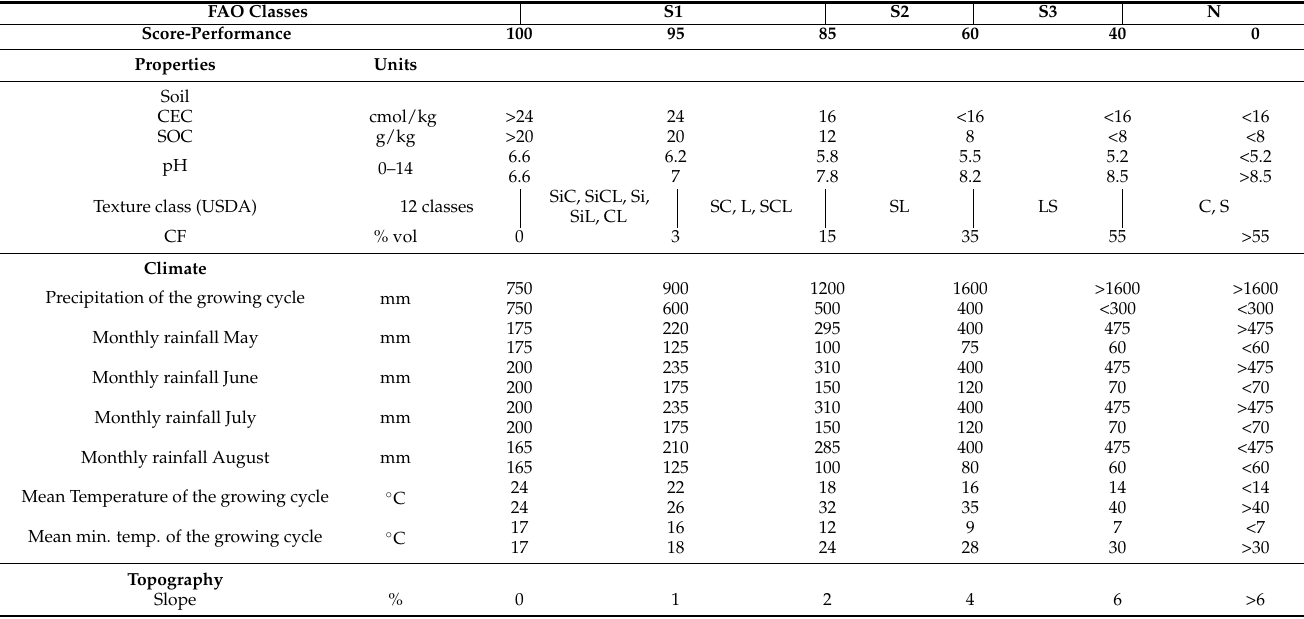
Table 2. Threshold values for available input parameters for